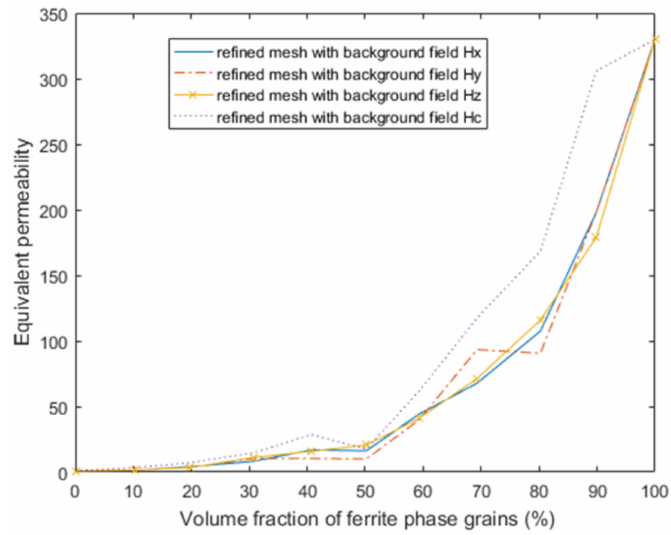
Figure 10. Equivalent relative permeability of austenite–ferrite in the RCPS-VM microstructure with varying phase fractions when the refined model is excited by different background field